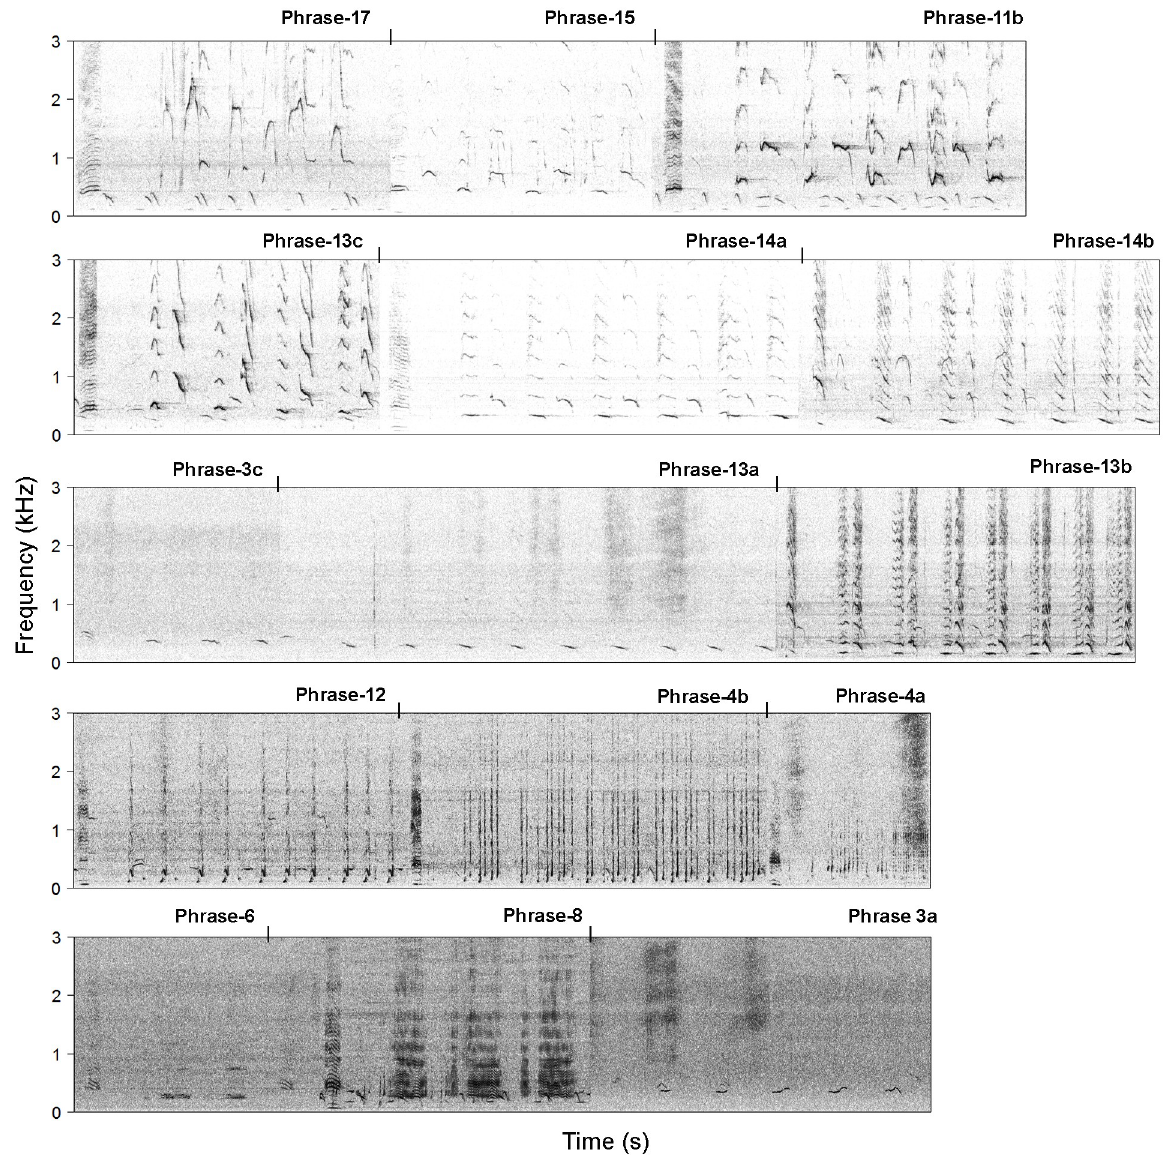
Fig 4. The observed phrases from 2011. Spectrographic representations of the observed phrases from the complete recording period. The spectrograms were generated using Fast Fourier Transformation (FFT) (size 2048 Hanning window) with a frequency resolution of 7.8 Hz and a 95% overlap. The vertical, black lines indicate the division between the phrases. Audio is provided in S1 Acoustic